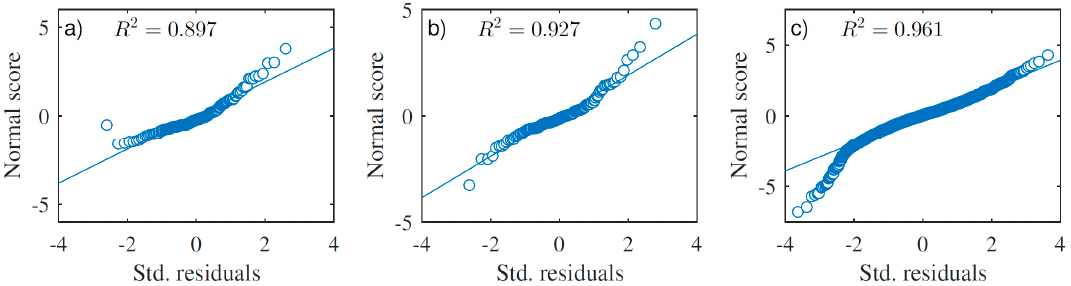
Figure 6. Normal probability plot of the standard residuals: ( a ) design regression model #1, ( b ) design regression model #2, ( c ) off-design regression model (R = 0.897; 0.960).